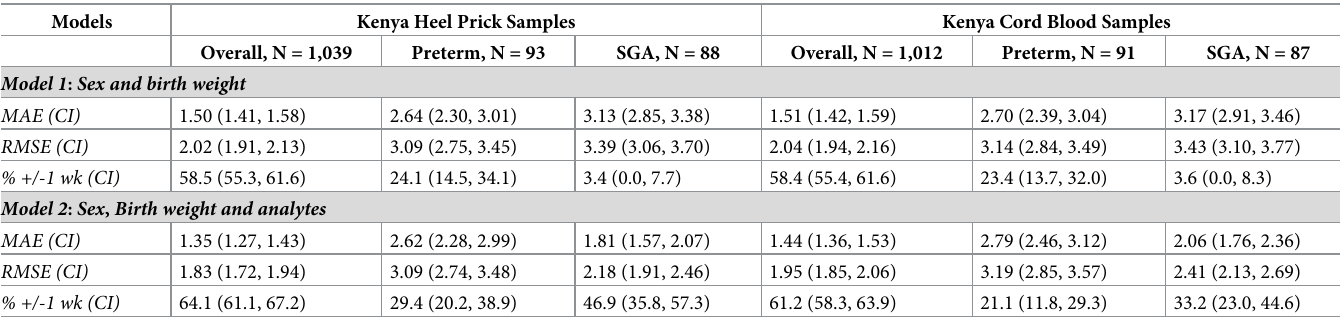
Table 3. Summary of model performance to estimate gestational age in samples from Kenya.